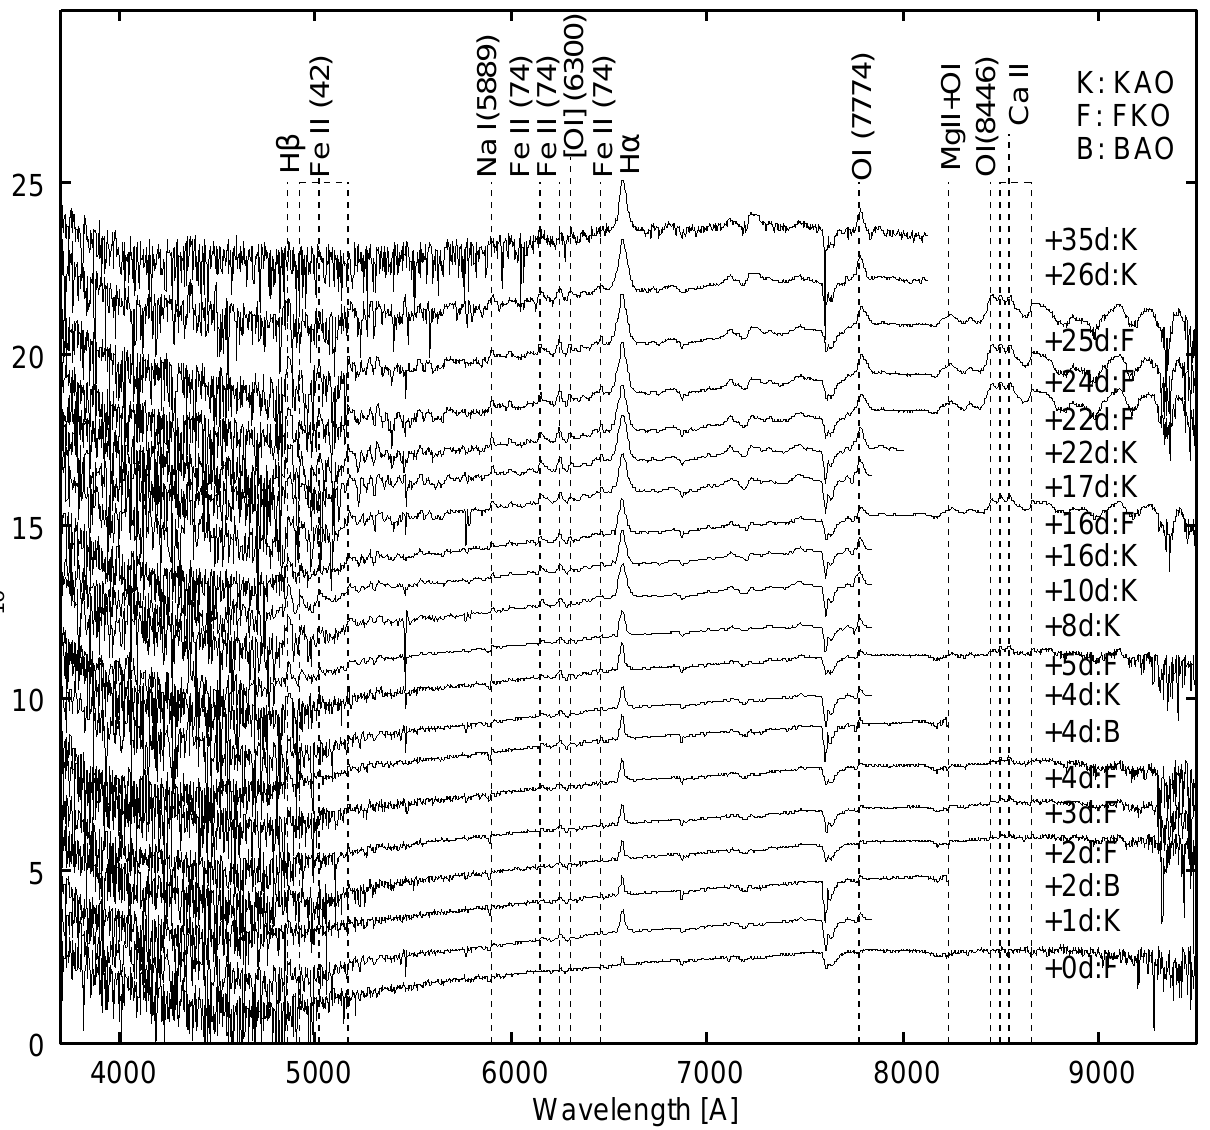
Figure 1: Low-dispersion spectra of V1724 Aql obtained at three sites from 2012 Oct 21 to Nov 25 UT. All spectra are shifted by different offsets for readability. Emission lines were on the highly red continuum. The line width of H α emission became broader and stronger compared with the nearby continuum, and the Ca II triplet emission lines bacame stronger later. Note that the bluish continuum might overlap with the spectra of the nova in the shorter wavelength region ( λ < 4500 ˚ A ), probably due to a forground (or background) star.